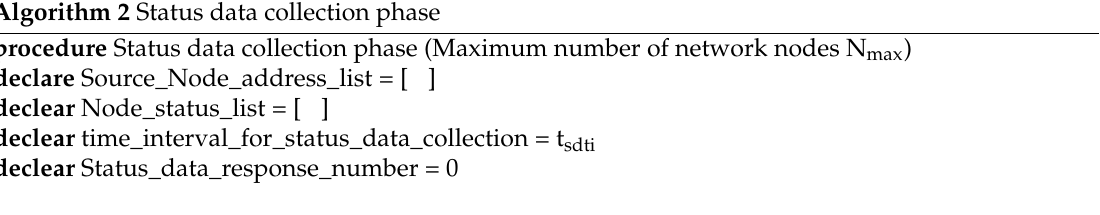
Algorithm 2 Status data collection